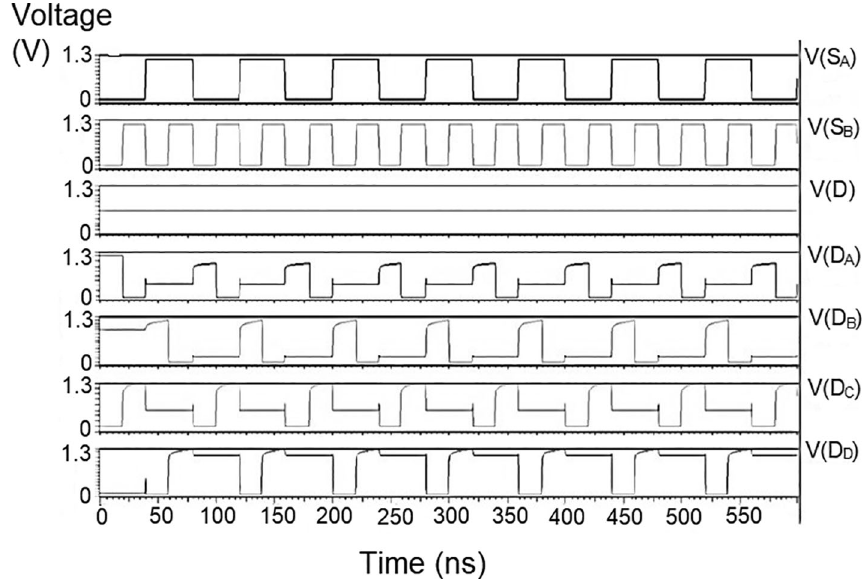
Figure 5(b). Voltage vs time simulation at 1.3 V for 180 nm.